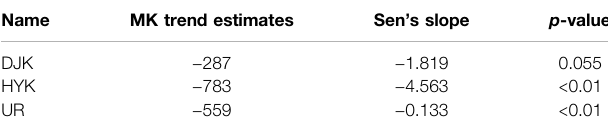
TABLE 2 | Results of MK and Sen ’ s slope trend tests from 1961 to 2018.